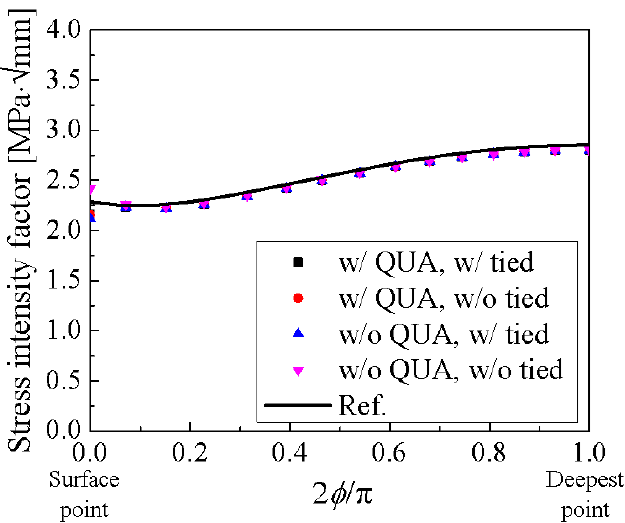
Figure 5. Comparison of SIF according to element types [22].